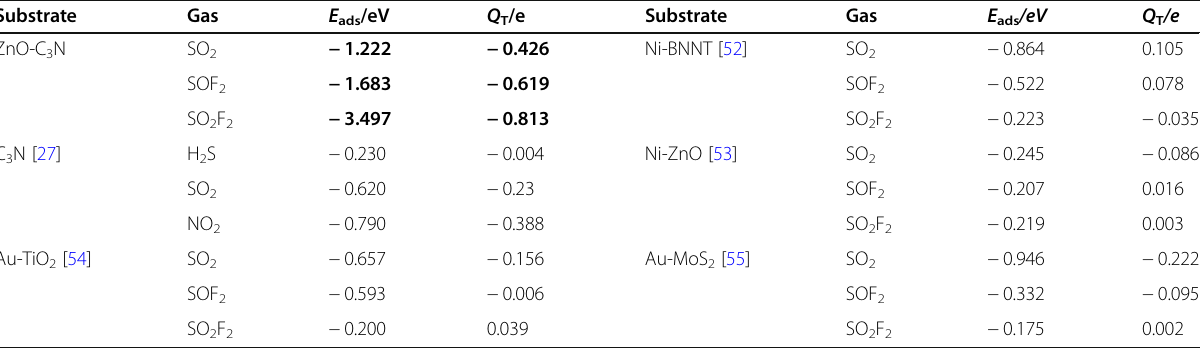
Table 1 The adsorption configuration comparison of ZnO-C 3 N monolayer and other nanomaterials